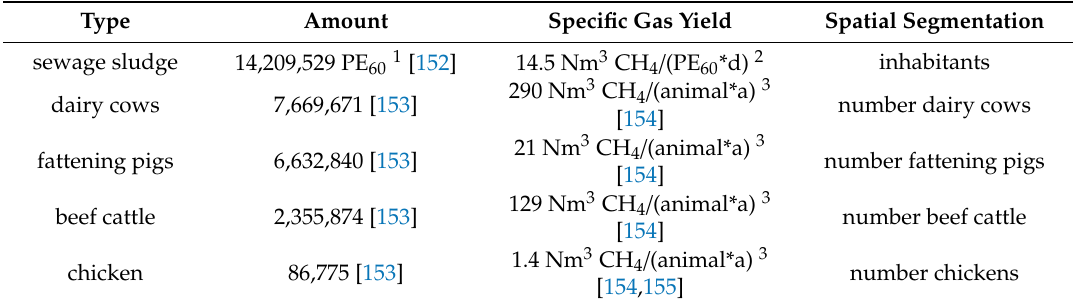
Table 8. Considered sewage sludge and animal excrements as biogas potential. All values are only published for the whole of Austria.